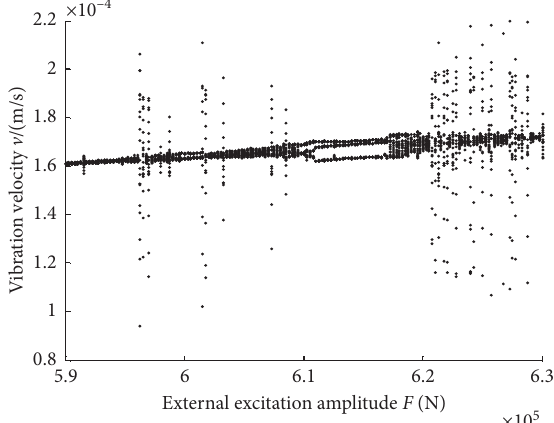
Figure 7: Bifurcation characteristics of rolling mill system.